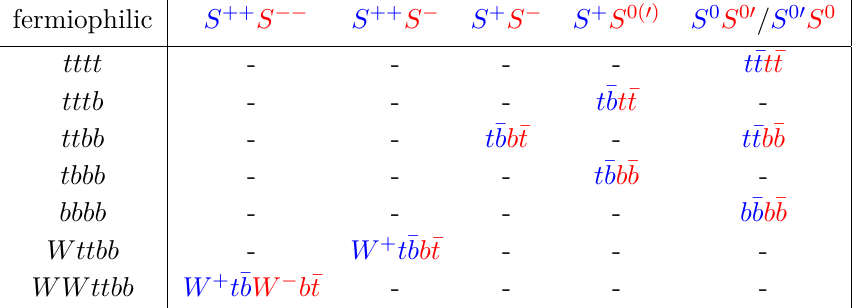
Table 2. Classification of the 8 di-scalar channels in terms of the 5 pair production cases (columns) and the 5 combinations of top and bottom from decays (rows). In cases with one or two doubly charged scalars, one always obtains ttbb with one or two additional W ’s, respectively. The charge- conjugated states are not